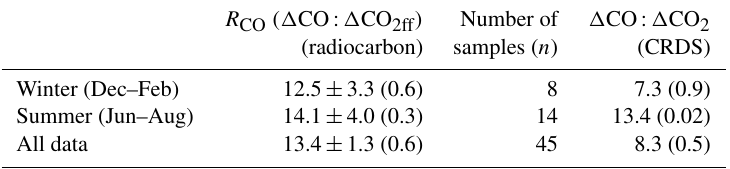
Table 1. Ratios ( R CO ) determined using radiocarbon measurements after correcting for influence from NPPs and applying model II re- gression, and ratios derived from continuous CO and CO 2 measurements by the CRDS analyzer as enhancements ( (cid:49) CO: (cid:49) CO 2 ) using Jungfraujoch background measurements. R CO values are given in mmolmol − 1 with standard uncertainties of the slope and r 2 values in brackets, and n represents the number of samples for the radiocarbon method. Note that, according to the Swiss emission inventory report for greenhouse gas emissions in 2013, the annual anthropogenic CO / CO 2 emission ratio for the national estimate is 7.8mmolmol − 1